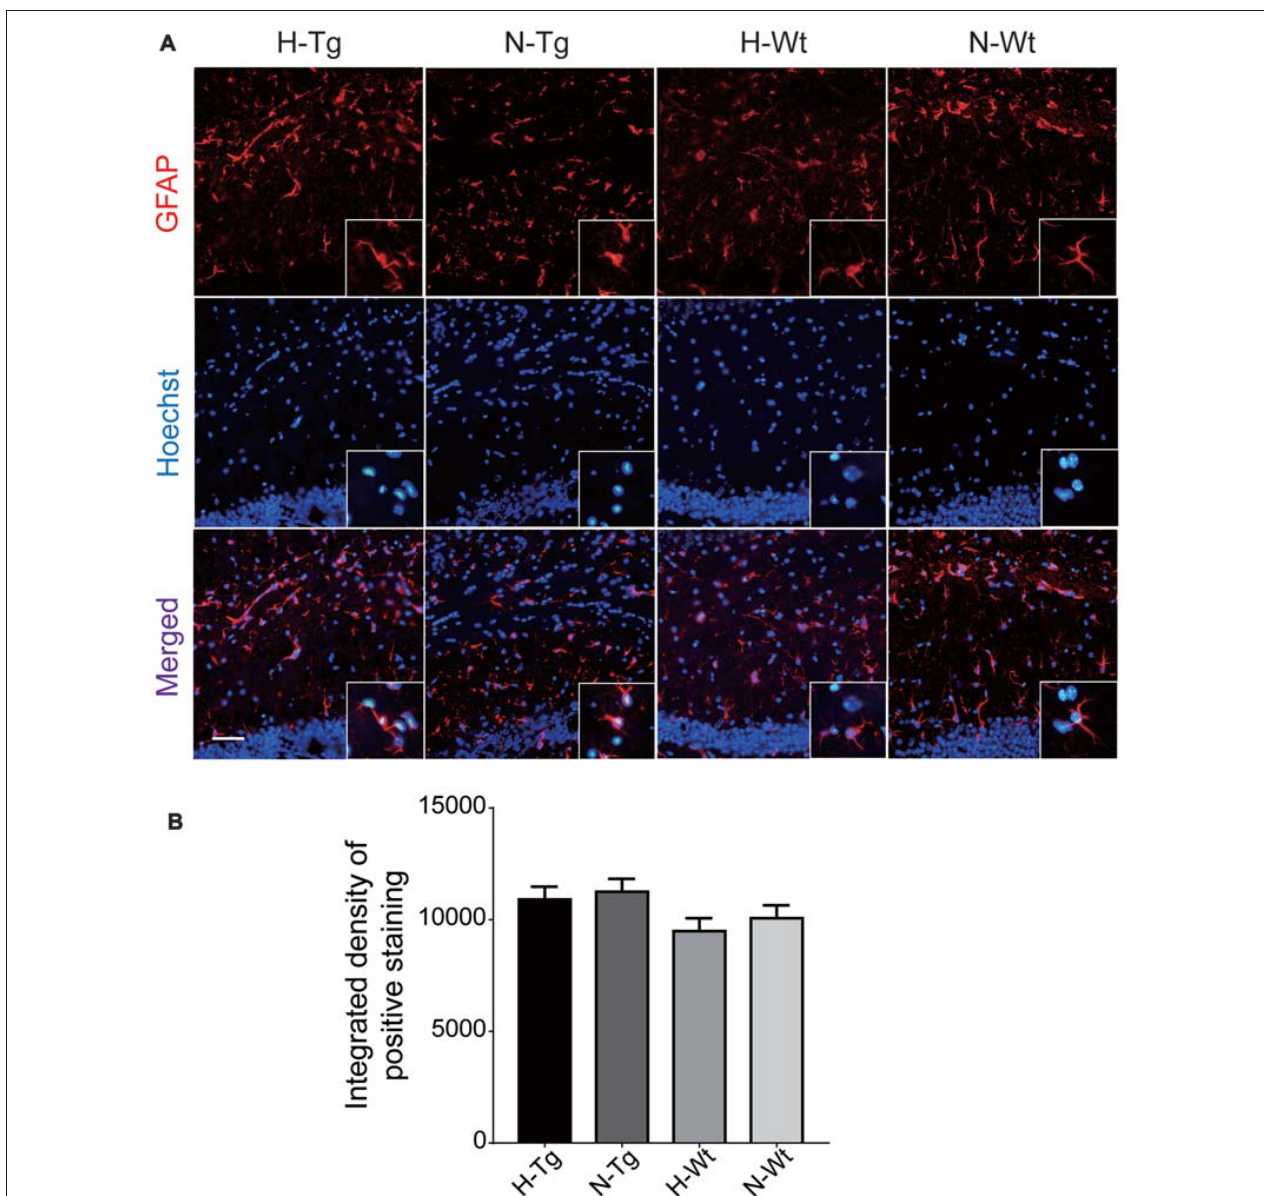
FIGURE 2 | Immunoflourescence staining of astrocytes in mouse hippocampus after acute hypoxia. Astrocytes were detected by glial fibrillary acidic protein (GFAP) antibody (A) . The GFAP immunostaining revealed no alteration in hippocampal astrocytes after acute hypoxia exposure (B) . Scale bar: 50 µ m, n = 3 in each group. Data were the mean ± SEM